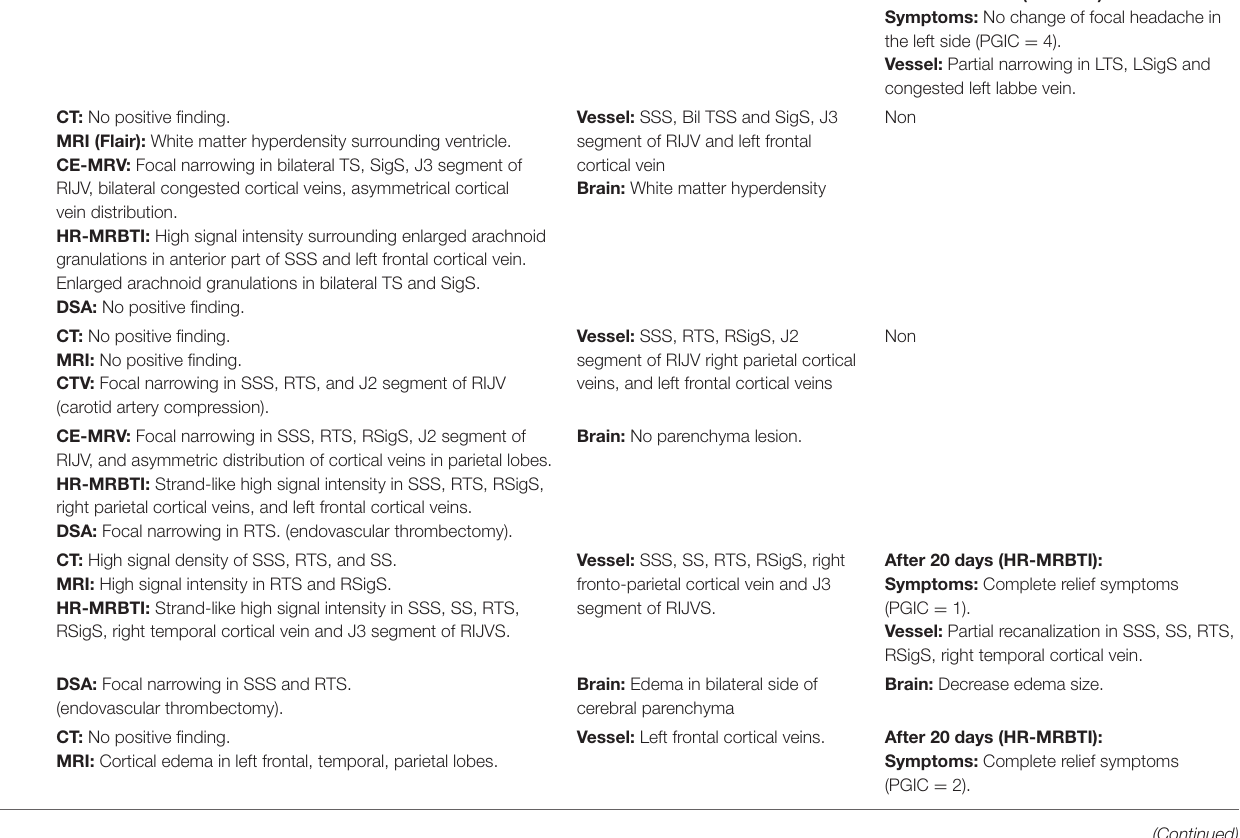
Brain: Decrease edema size.